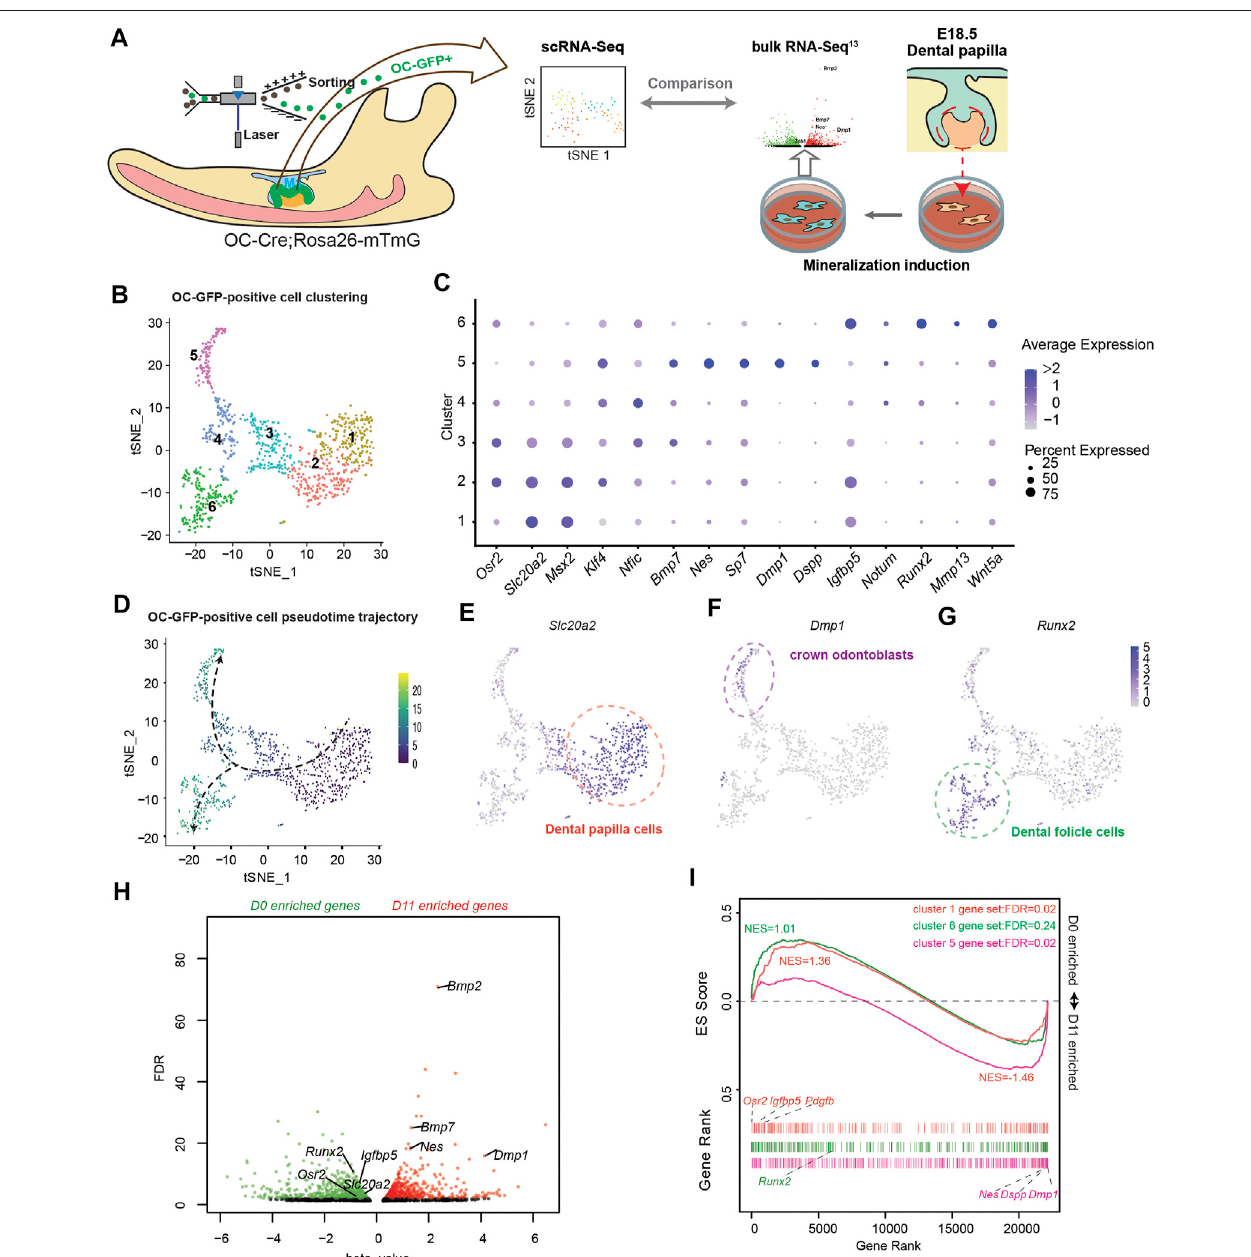
FIGURE 1 | Comparison between in vitro odontoblastic differentiation and in vivo osteocalcin (OC)-positive odontogenic lineage differentiation. (A) Study design comparing single-cell RNA-seq (scRNA-seq) using OC + odontogenic lineage from postnatal day 0 (PN0) fi rst lower molar tooth germ and bulk RNA-seq of dental papilla cells before and after mineralization induction. (B) t -distributed stochastic neighbor embedding (tSNE) depicting the clustering of 975 single-cell transcriptional pro fi les obtained from FACS-sorted GFP-positive cells from OC-Cre and Rosa26-mTmG PN0 fi rst lower molar tooth germ. (C) Dot-plot showing expression and enrichment of selected top genes identi fi ed in each cluster. The size of dot indicate the percentage of cells per cluster. (D) Pseudotime- trajectory of OC-GFP-positive scRNA-seq. (E) Slc20a2 marks pre-odontoblast population in OC + odontogenic lineage. (F) Dmp1 marks crown odontoblast population in OC + odontogenic lineage. (G) Runx2 marks dental follicle cell population in OC + odontogenic lineage. (H) Volcano scatter plot showing the differentially expressed genes revealed in bulk RNA-seq from dental papilla cells before (D0) and after (D11) mineralization induction. Red dots indicate genes signi fi cantly enriched in D11, and green dots indicate genes signi fi cantly enriched in D0. (I) Gene set enrichment analysis (GSEA) using marker genes from cluster 1 (orange), cluster 6 (green), and cluster 5 (violet) as gene sets comparing expression pro fi les from D0 and D11 bulk-RNA-seq. NES, normalized enrichment score; FDR, false discovery rate, as generated in GSEA.